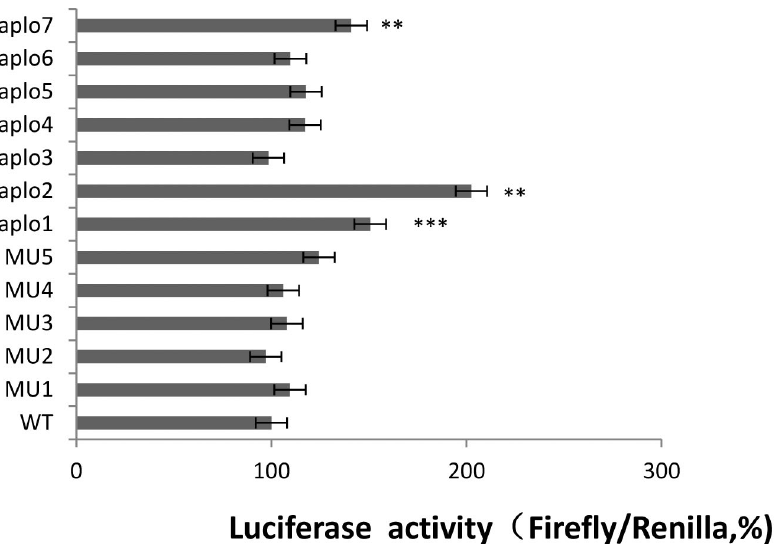
Figure 2. Expression of the human CYP2E1 reporter constructs in the human hepatoma cell line (Hep G2). The luciferase activities were normalized against the human wild type construct. The results are the average of at least three independent experiments. Comparisons among groups were done with the aid of the ANOVA statistical procedure. **Significantly different from Wild type transfected cells ( P , 0.05), *** Significantly different from Wild type transfected cells ( P , 0.01).